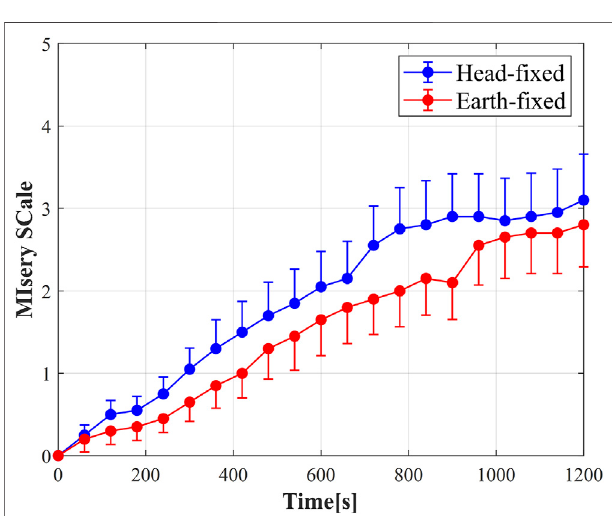
FIGURE 6 | MIsery